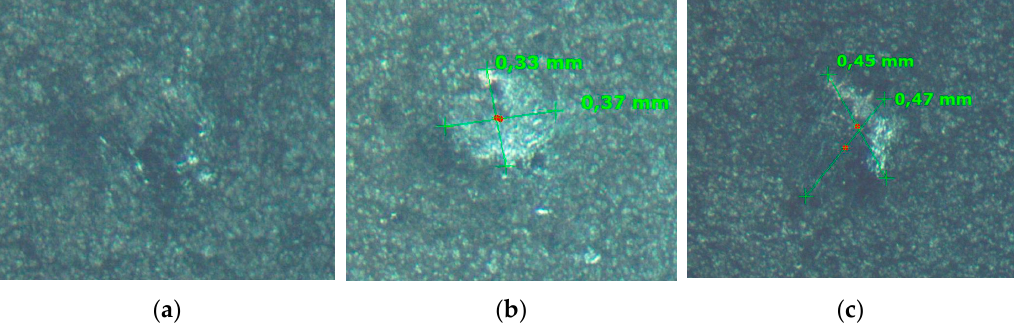
Figure 7. Scratch comparison between the IN625 and pure titanium cold sprayed coatings. The IN625 coating appears very compact at the maximum load ( left ) while the Ti coating shows particles decohesion around the scratch ( right ).